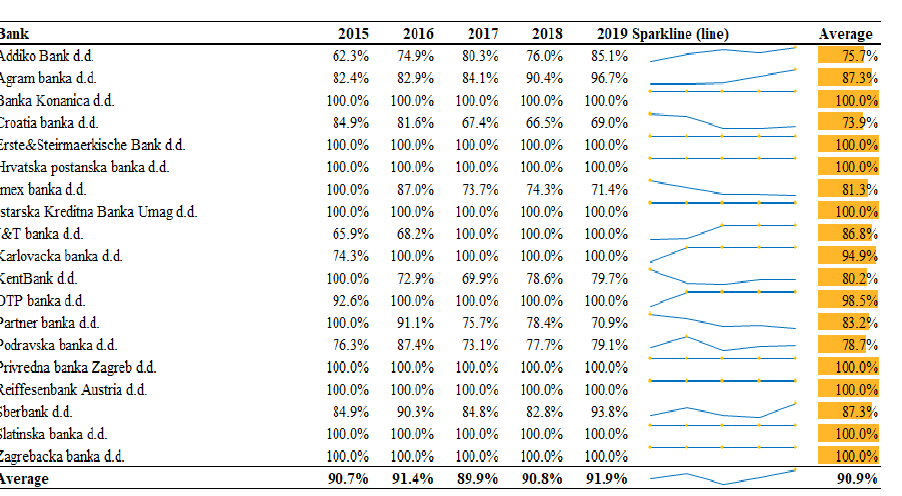
Figure 4. Targets for improvement for the inefficient Macedonian commercial banks (in 000 MKD Denars).